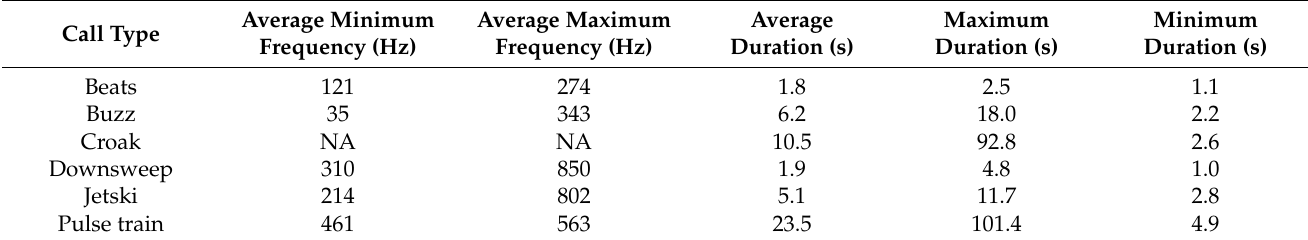
Figure 2. Images (created from spectrograms) of the six potential fish calls from the northern Gulf of Mexico recording location: ( a ) Beats, ( b ) Buzz, ( c ) Croak, ( d ) Downsweep, ( e ) Jetski, and ( f ) Pulse train. Time and frequency scaling are provided for a better sense of the call’s characteristics. The scaling and gray scale are the same for all images. Table 1. Frequency (average minimum and maximum) and temporal (average, maximum, and minimum duration) characteristics of the six fish call types based on 30 randomly selected calls of each call type.